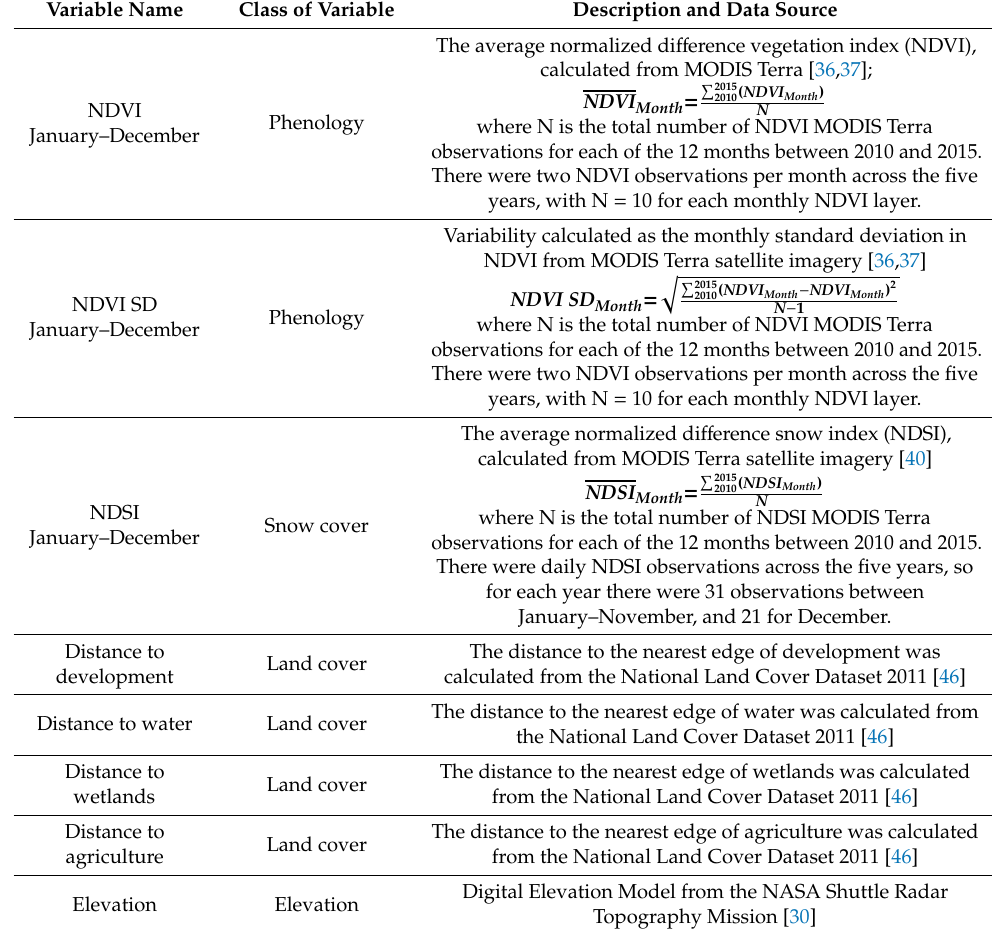
Table 1. Variables included in the random forest model. Listed are all variables used in the model, the ecological justification for their inclusion, and previous studies demonstrating the use of such